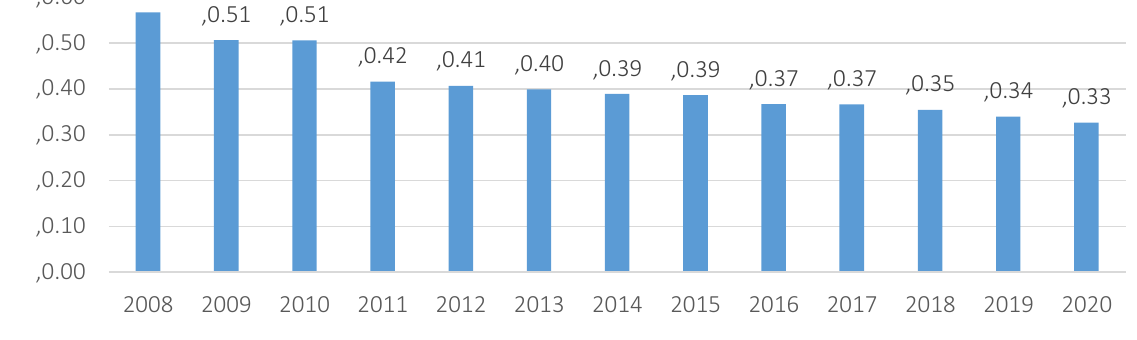
Figure 3. Sales of mobile phones per capita in the EU (27)